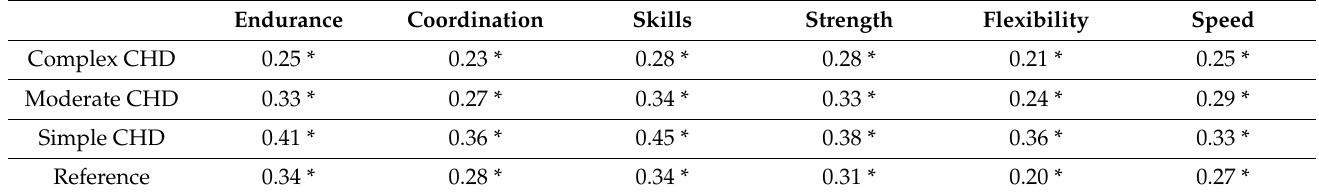
Table 6. Correlation of a positive self-concept with overall activity (per CHD group).